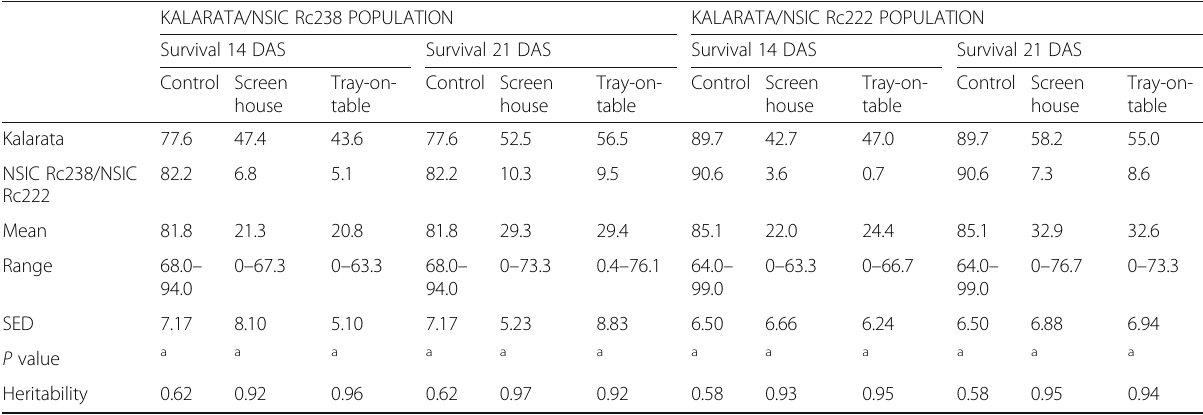
Table 1 Performance of Two Rice BC 1 F 2:3 Mapping Populations of Kalarata/NSIC Rc238 and Kalarata/NSIC Rc222 Along With Respective Parents for SUR Under Anaerobic Conditions During Germination